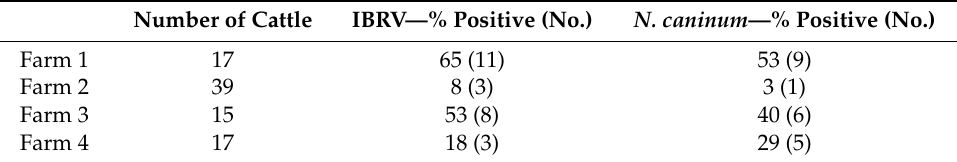
Table 2. Percentage of dairy cattle positive for antibodies to IBRV and Neospora caninum . Number of Cattle IBRV—% Positive (No.) N. caninum —% Positive